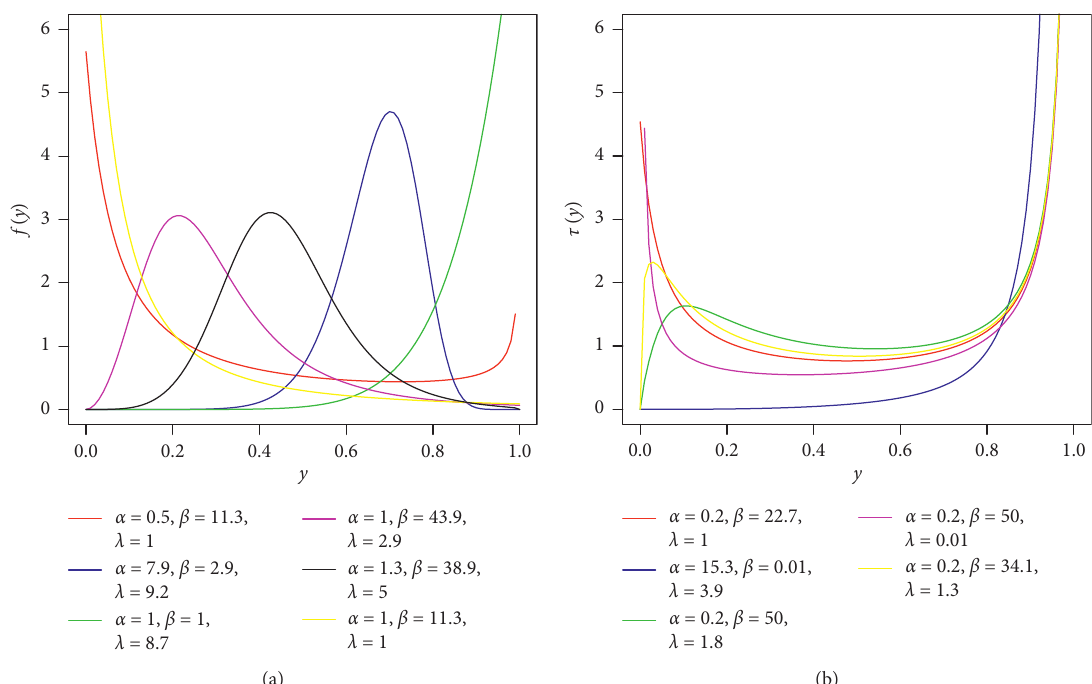
Figure 2: Plots of PDF (a) and hazard function (b) of BOIPE